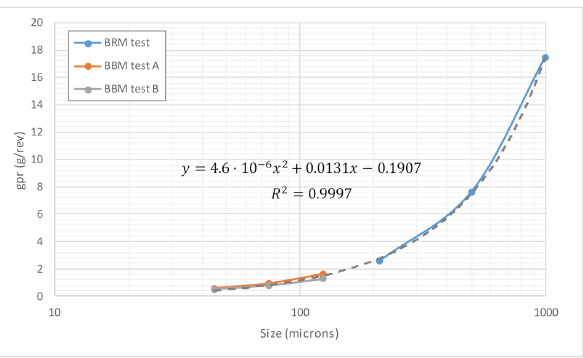
Figure 11. Variation of BBM and BRM gpr values with P 100 , Barruecopardo